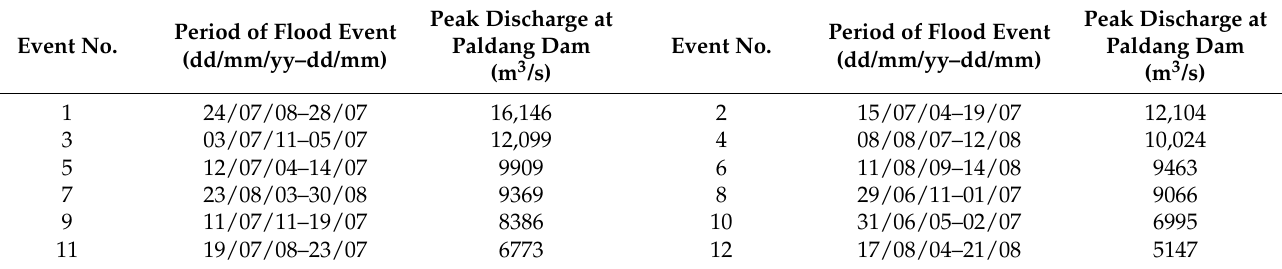
Table 1. Flood events used for calibration and validation of the hydrodynamic model.